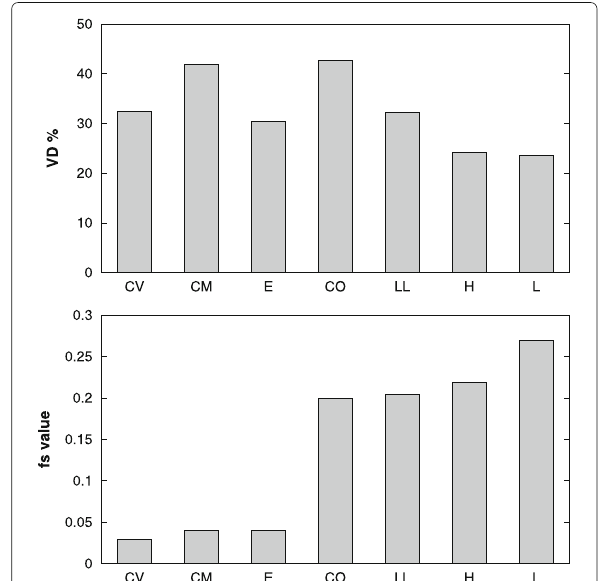
Fig. 5 Top panel: VD% of MLB predicted by the calculation for each type of chondrite, that obtains at the moment of ejection of the droplets which would acquire the average chemical composition of chondrules by subsequent incorporation of the vapor and condensate. Bottom panel: the f s value of CI sil determined by the calculation for each type of